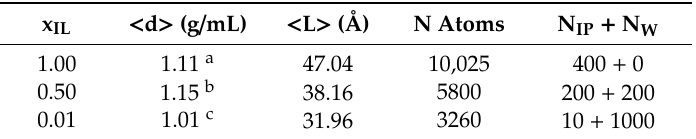
Table 3. Some properties of the simulated systems in the NPT ensemble (300 K, 1 atm): Equilibrium average density, < d > ; average length of the cubic box side, L; total number of atoms in the box, N; composition, N IP ion pairs + N W water